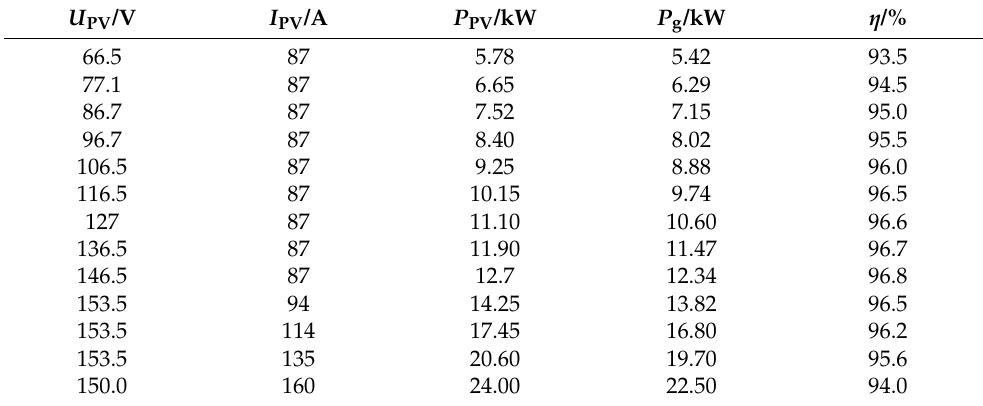
Table 3. PV wide power fluctuations efficiency measurement.